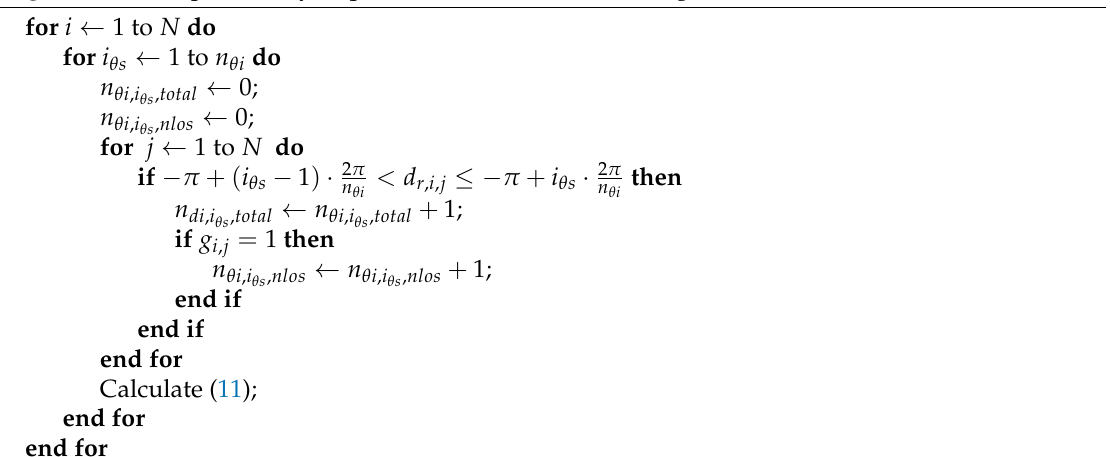
Algorithm 2 The probability acquisition method related to